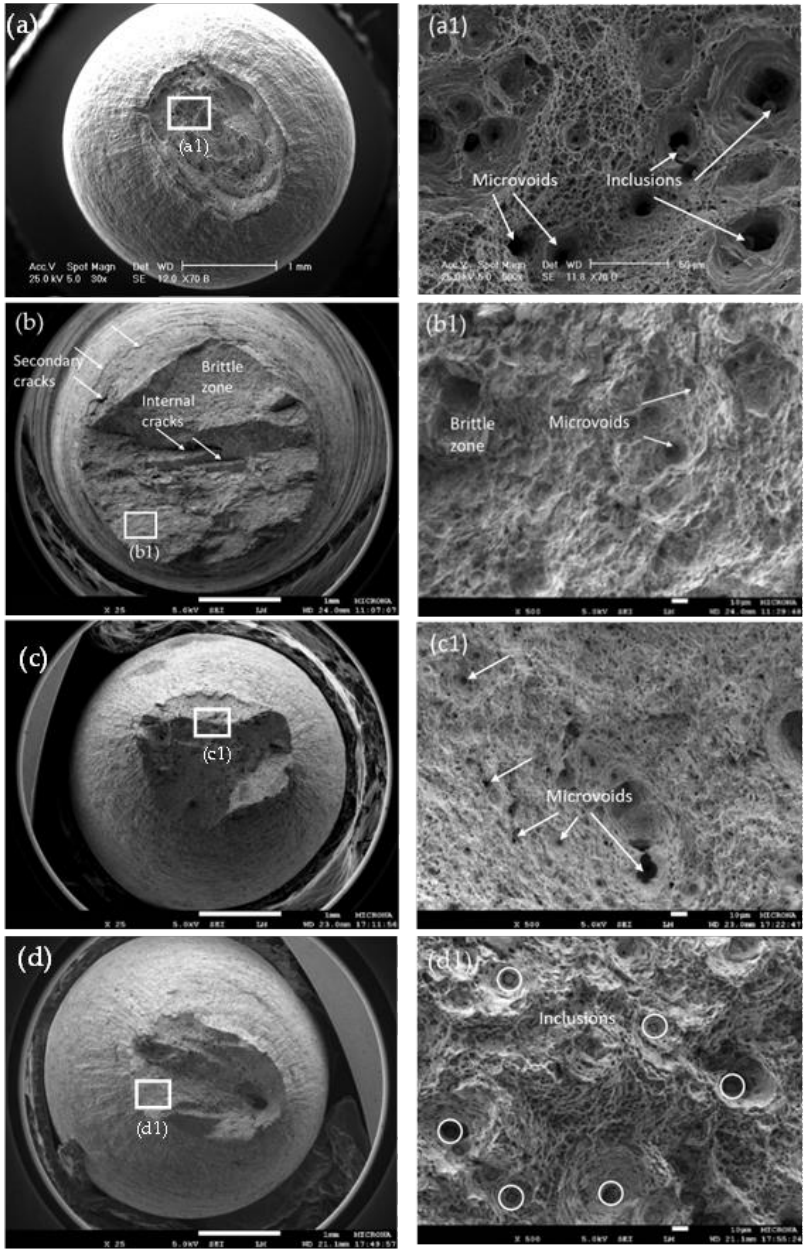
Figure 3. SEM micrographs of fracture surfaces of the X70 steel after SSRT tests in air ( a , a1 ) and the NS4 solution at different pH values: ( b , b1 ) pH 3 ( c , c1 ) pH 8 and ( d , d1 ) pH 10.